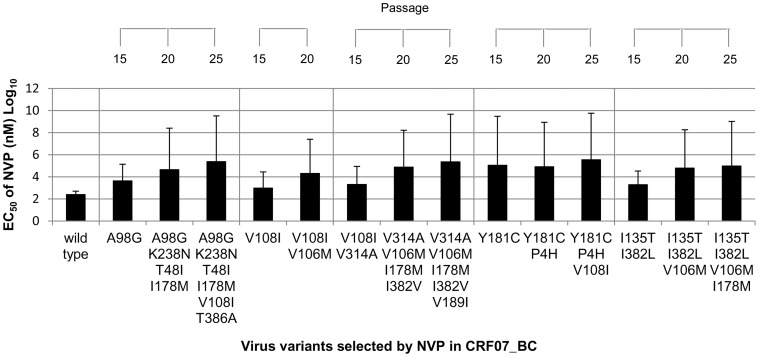
Phenotypic analysis of CRF07_BC virus variants selected by NVP.The NVP EC50 of CRF07_BC virus variants with different mutations were shown. TZM-bl cells were infected with virus variants and treaded with serial diluted NVP. After 48 hrs incubation, luciferase activities representing HIV infection were tested. The EC50 NVP was estimated from the standard curve plotted by the percentage of reduction of luciferase activity and serial concentrations of NVP.